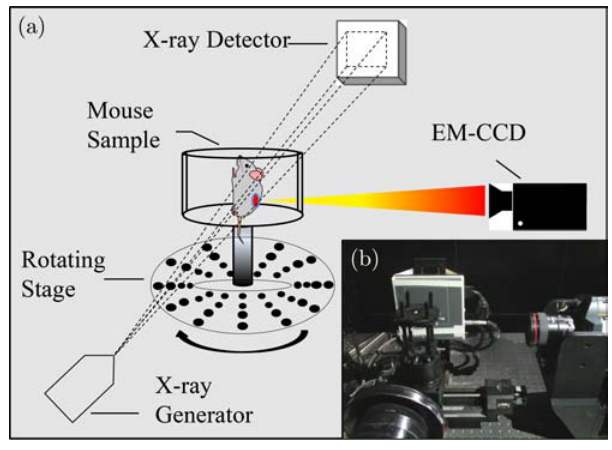
Fig. 2. The POBT and DMT dual BLT imaging systems. (a) The schematic illustration of the POBT and DMT systems. Both systems shared the same rotating stage, but the under- neath calibration mat was only used for the POBT technique. (b) A picture of the system set-up, including the cooled EM- CCD, X-ray generator, X-ray detector, and Rotating